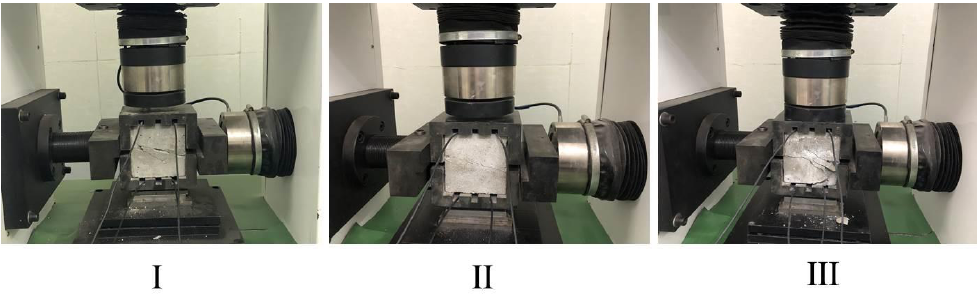
Figure 12. Composite specimens after shear failure .